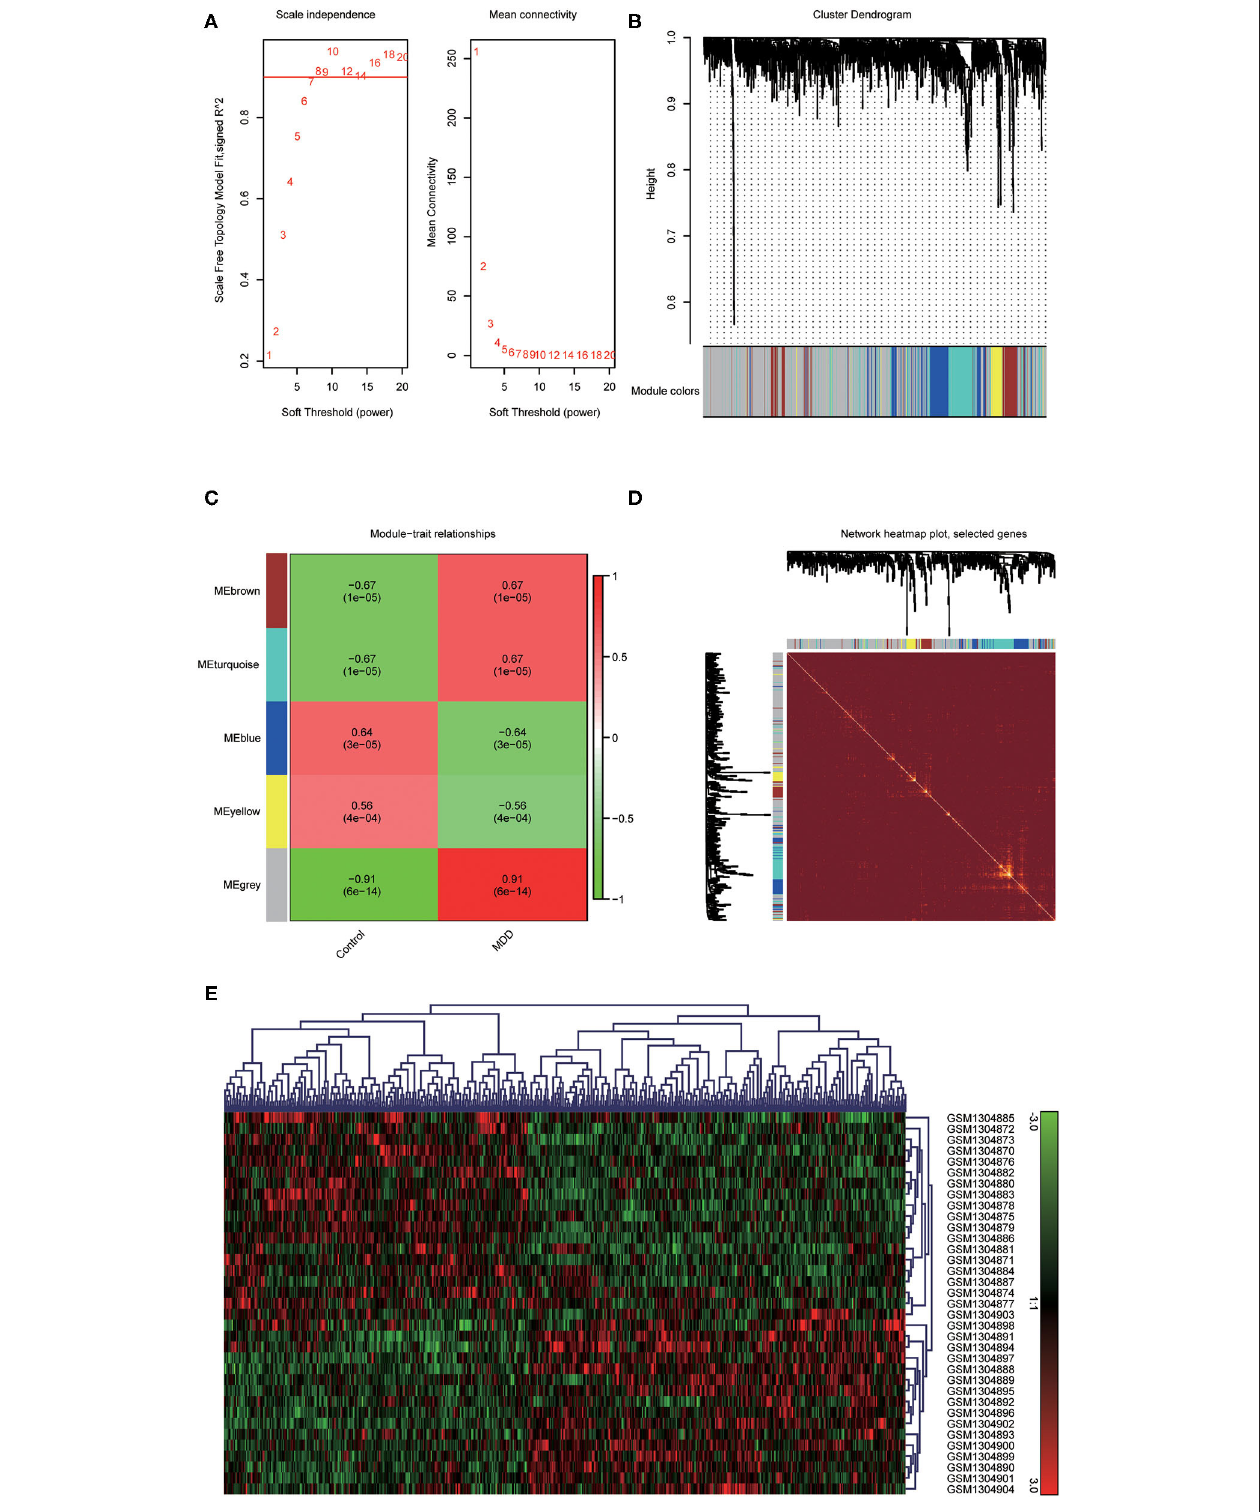
FIGURE 1 | Construction of a weighted gene co-expression network analysis. (A) Selection of soft threshold; (B) Co-expression network of differential expressed genes from GSE53987; (C) Disease-related module: the words at the top of every module refer to the correlation index, and the words in brackets refer to the p -value; (D) The heatmap of the correlationship between modules of the selected genes; (E) The clustered gene expression heatmap of MEgrey module.